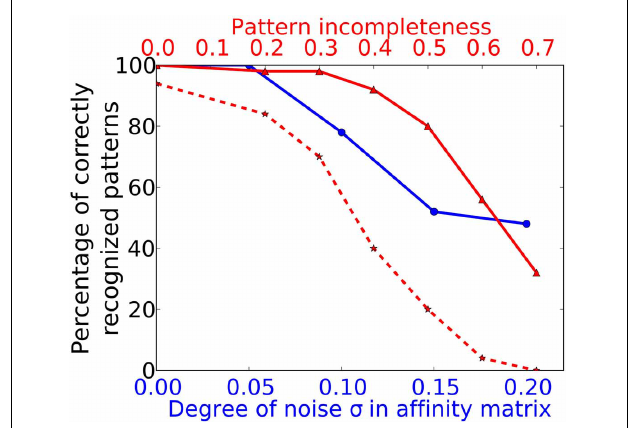
FIGURE 5 | Performance in Task 3 (noise robustness) and Task 4 (pattern completion). The system as trained to 50 complete and noise free patterns (as in Task 1) is exposed to odor patterns with increasing number of deactivated ORs and to patterns with increasing degree of noise. The blue curve marked with circles corresponds to the lower x-axis and shows performance in Task 3. The red curve with solid lines and triangle markers corresponds to the upper x-axis and shows performance in Task 4. The dotted red curve with star markers shows the Task 4 performance of a network without recurrent long-range connectivity in PC as trained in Task